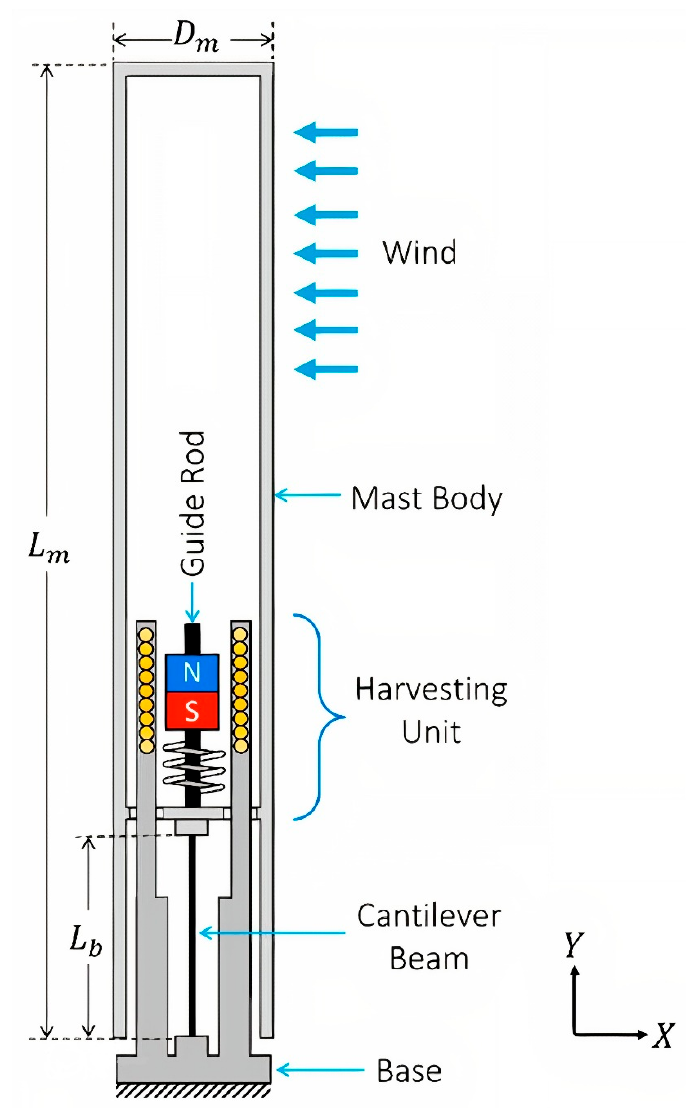
Figure 4. Schematic drawing of a bladeless wind turbine [69]. (Open Access).